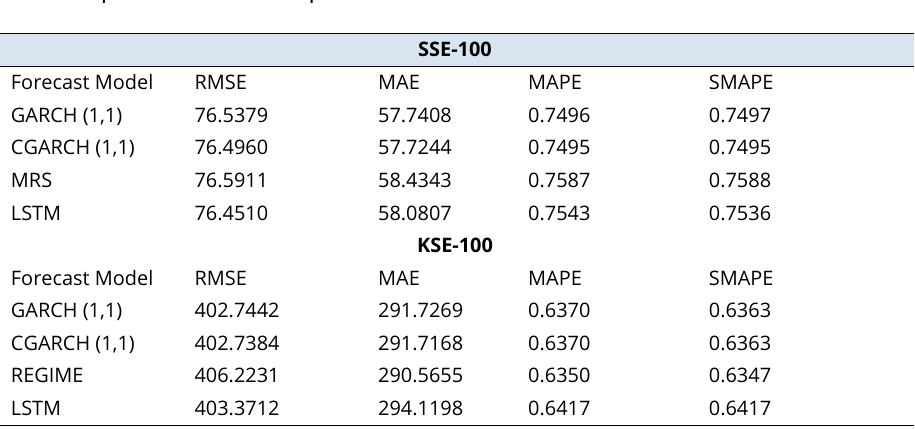
Forecast performance